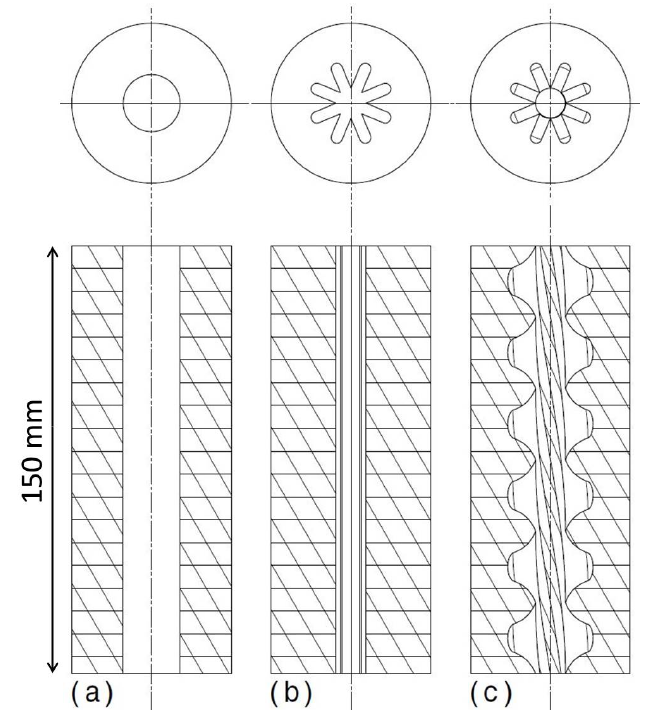
Figure 1. Overview over the different fuel block geometries: ( a ) Monoport; ( b ) Star; ( c ) rotated Star [15].